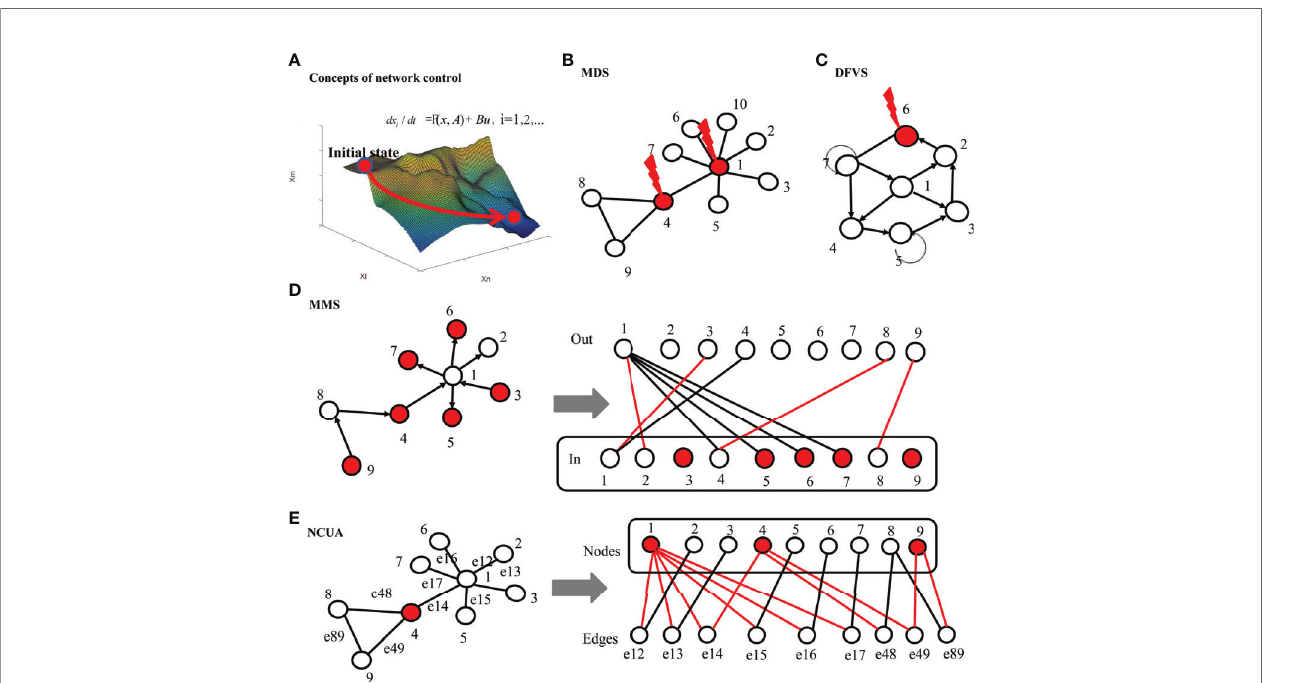
FIGURE 2 | The principles of different network control methods. (A) Concept demonstration of network control methods. Network control tools aim to detect a small number of driver nodes which form the input matrix and are injected by the input signals for driving the state transition of high dimension networked system depending on adequate knowledge of the network structure. (B) MDS based control methods. If the connected edges of MDS are removed, there will be no edges in the network. By assuming that the driving node can independently control all neighbor nodes, the minimum dominating set (MDS) in the undirected network is taken as the set of driver nodes, and the red node represents the minimum driving node. (C) DFVS based control methods. The red nodes represent the minimum set of feedback nodes (FVS), that is, if the connected edges of FVS are removed, there will be no loops in the network. For FVS based control methods, by controlling the nodes in FVS, the whole system can be transformed from one stable attractor to another attractor. (D) MMS based control methods. The directed network is transformed into a bipartite graph. For the bipartite graph, the upper side represents the out degree of the original network, while the bottom side represent the in degree of the original network nodes. If there is an edge from one node to another node in the original network, an edge connecting these two nodes is added to the bipartite graph. According to the maximum matching of bipartite graph, the maximum matching (i.e., red edges) can be obtained, and 6 unmatched nodes (i.e., red nodes) can be found in the bottom side of bipartite graph. By controlling these 6 nodes, the system structure can be completely controllable for MMS based control methods. (E) NCUA based control methods. Firstly, the original undirected network is transformed into a bipartite graph, in which the upper side represents the nodes of the original network and the bottom side represent the edges of the original network respectively. Then, the nodes covering the nodes on the bottom side (i.e., red nodes) are obtained in the bipartite graph and are considered as driver nodes for the NCUA method. The red edges represent the links between the driver nodes and the nodes of bottom side in the bipartite